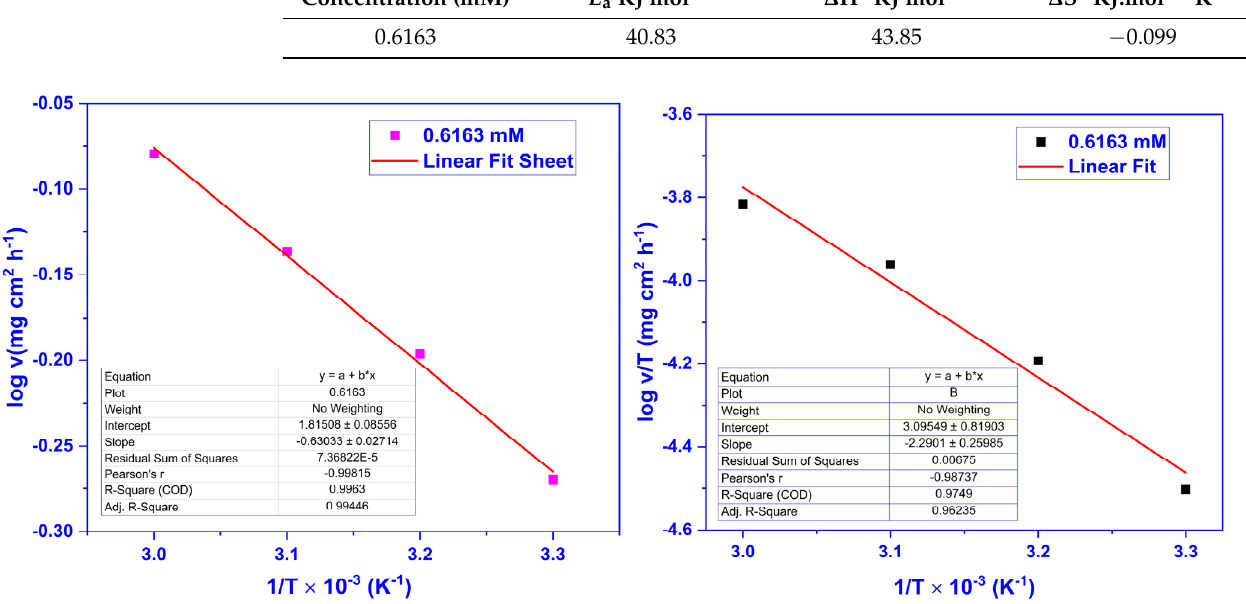
Figure 3 . Arrhenius ( Left ) and Eyring ( Right ) plots for mild steel at 0.6163 mM dosage of CMEA at various temperatures in 1 M HCl. Table 2. Activation parameters obtained for MS corrosion in 1 M HCl solution in the 0.6163 mM CMEA.